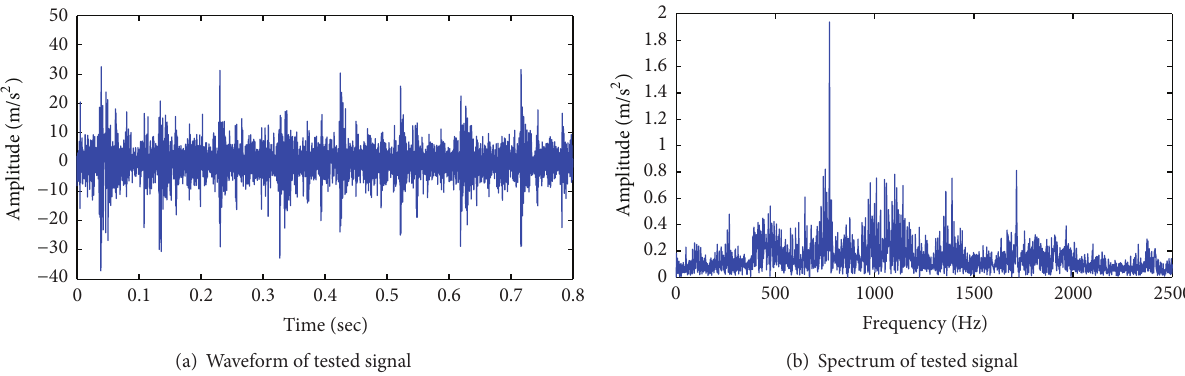
Figure 3: Waveform and spectrum of tested signal.